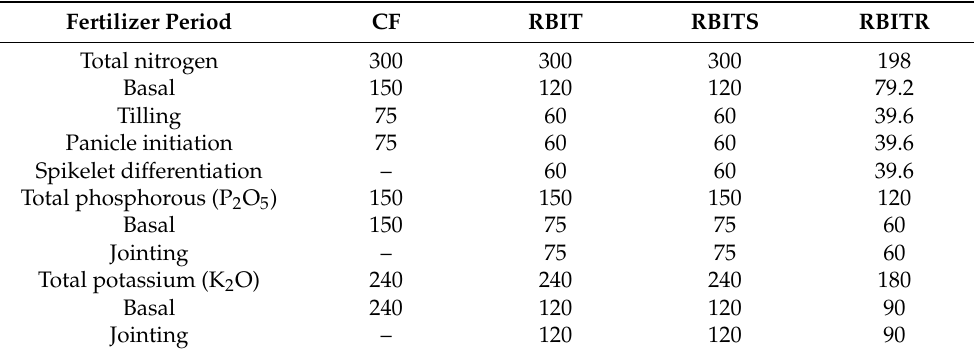
Table 1. Fertilizer application rates at different growth stages of rice under different fertilization management